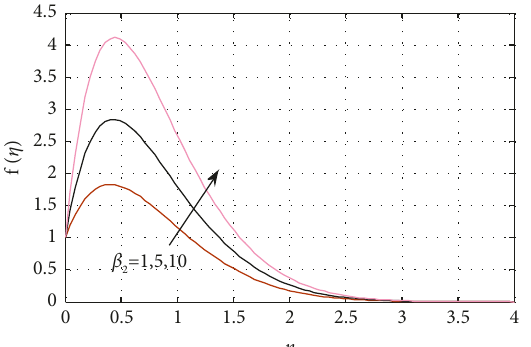
Figure 2: Impact of the thermal Grashof number on the velocity � 0 . 1 , Gr � 5 , ε � 0 . 1 , β � 0 . 4 , Gr profile using A � 1 , v m 0 1 1 P � 4 , R � 0 . 1 ,S � 1 . 5 , c � 0 . 4. r d c 1